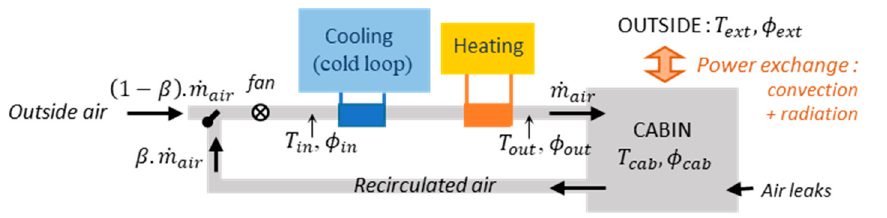
Figure 1. Schematic diagram of the HVAC system.